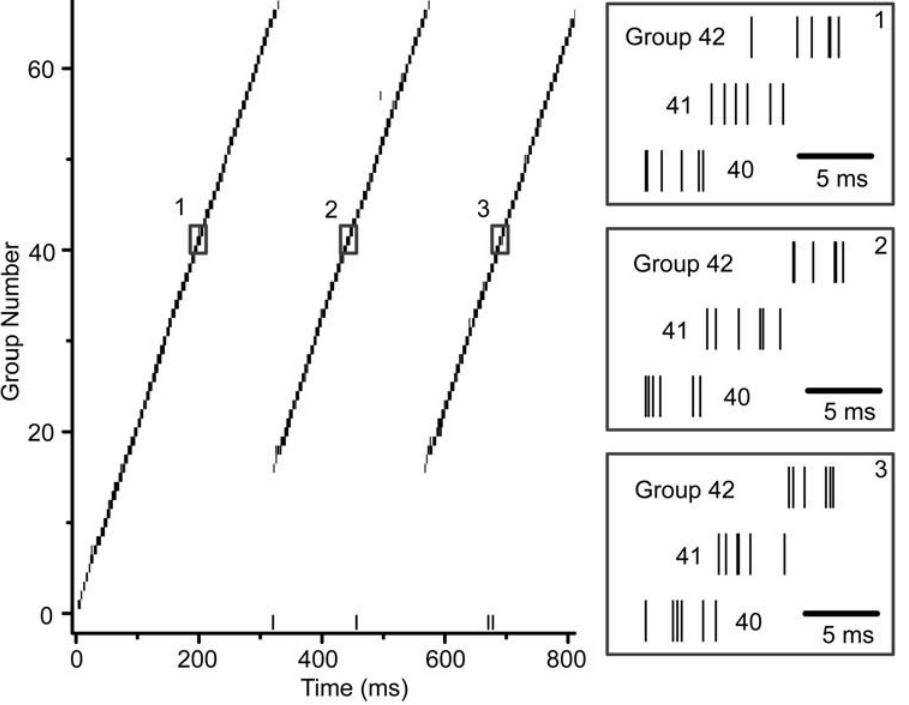
Figure 5. Cycles in spike activity. The raster shows activity in the network of Figure 5 later in development (Trial 300000). At this point, the network has developed a cycle that replays a portion of the chain activity. Insets show a detail of the same group of neurons in three consecutive cycles.